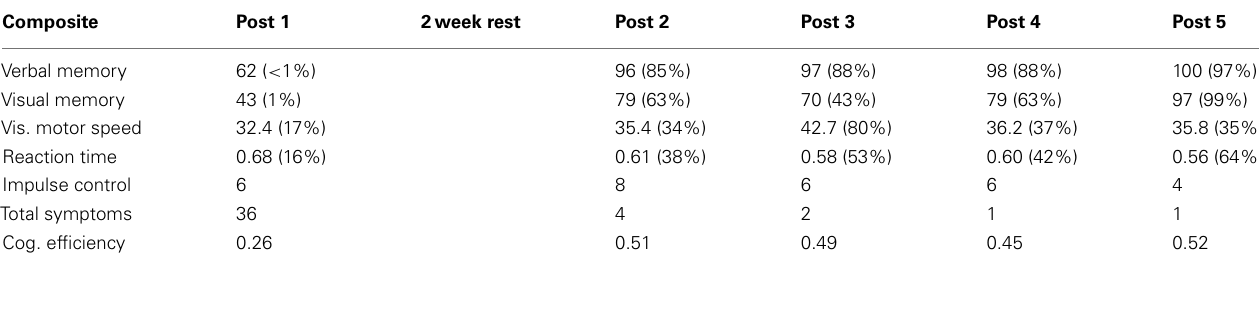
Table 1 | Case study ImPACT results (no baseline